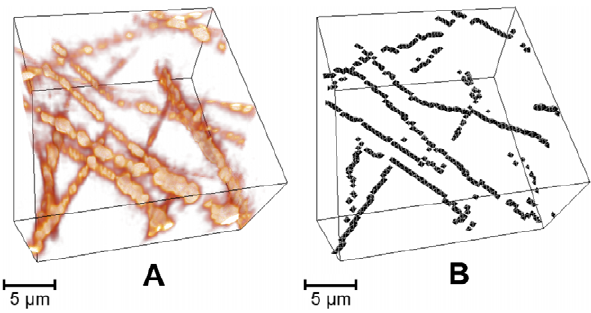
Figure 1. Small 3D stack of a collagen gel . Dimensions (20 | 20 | 10) m m 3 , collagen concentration 1.2 mg/ml. (A) Raw data, as recorded with confocal reflection microscopy, without any image processing. The lateral (x-, y-direction) resolution of the fibers is considerably better than the vertical (z-direction) resolution, due to the anisotropic point spread function. In addition, only fiber segments that run in small angles to the imaging plane are visible, due to the so-called blind spot effect. Moreover, the speckled appearance of the collagen network is an optical artifact of reflection microscopy; confocal images of fluorescently labeled collagen networks reveal continuous line networks [16]. (B) Corresponding reconstruction result, using the algorithm described in this paper. Note that voxels that appear to be missing in the reconstruction are located outside of the selected sub volume.